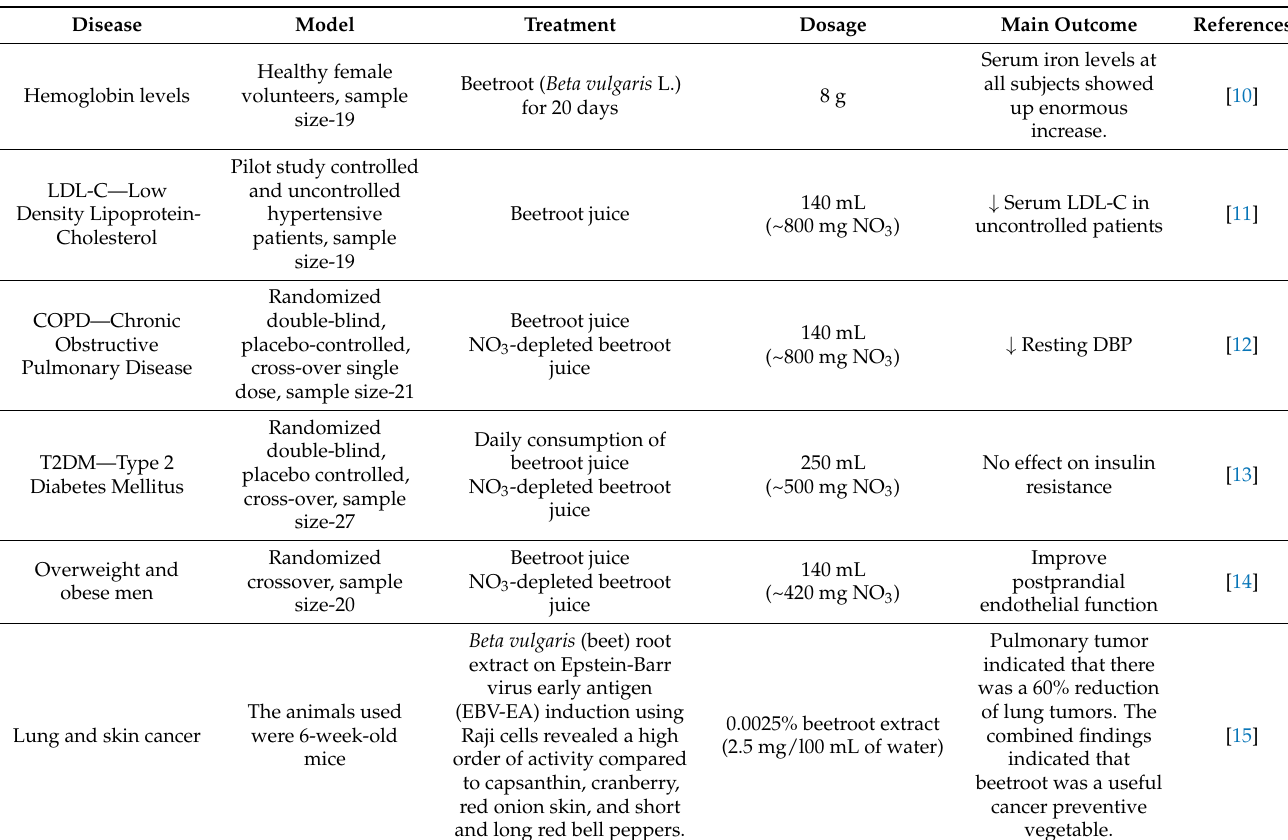
Table 2. Role of beetroot ( Beta vulgaris L) in health-related disease